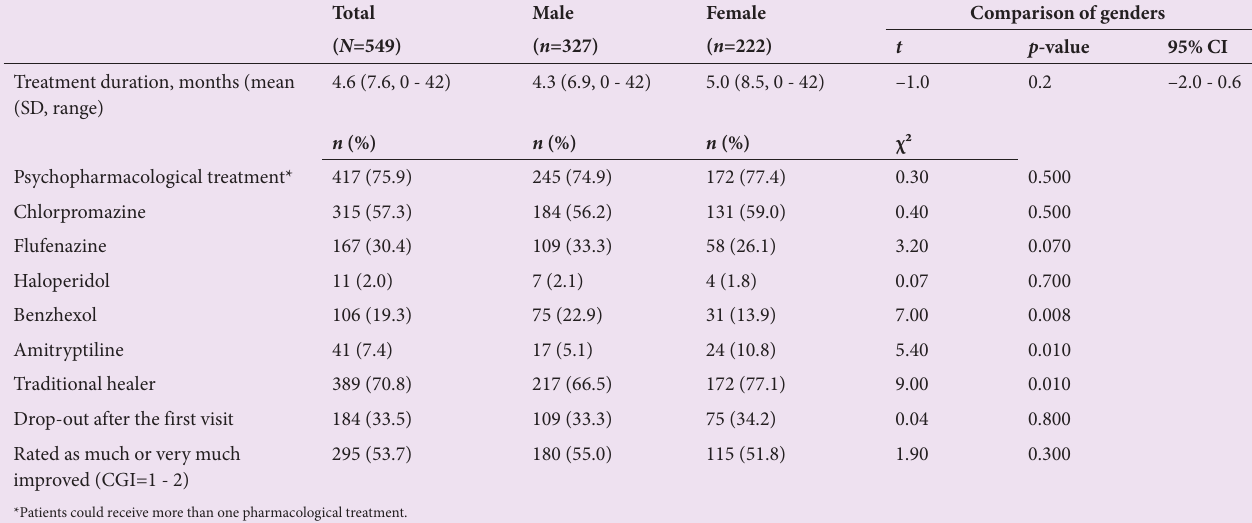
Table 3. Pharmacological treatment implemented in the mental health programme